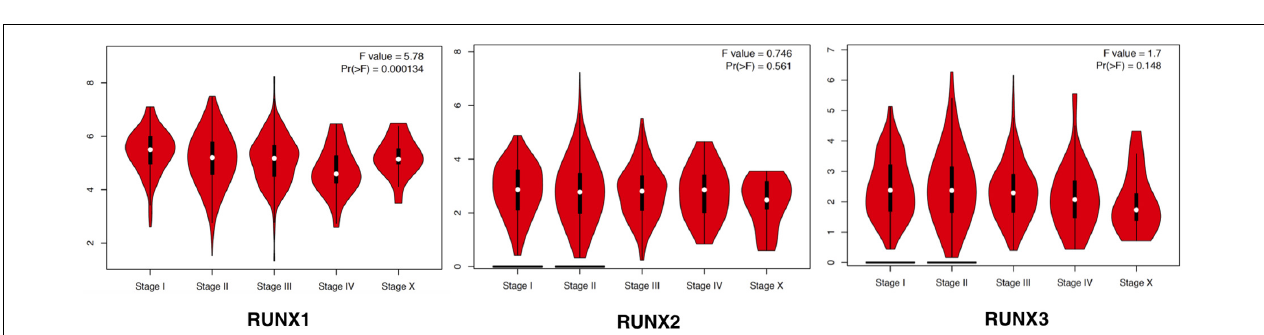
FIGURE 1 | The transcriptional levels of Runt-related transcription factors (RUNXs) in different types of cancers. (A) The transcriptional levels of RUNX1, RUNX2, and RUNX3 in various cancer tissues compared with normal tissues. (B) The transcriptional levels of RUNX1, RUNX2, and RUNX3 were compared across various The Cancer Genome Atlas (TCGA) tumors.